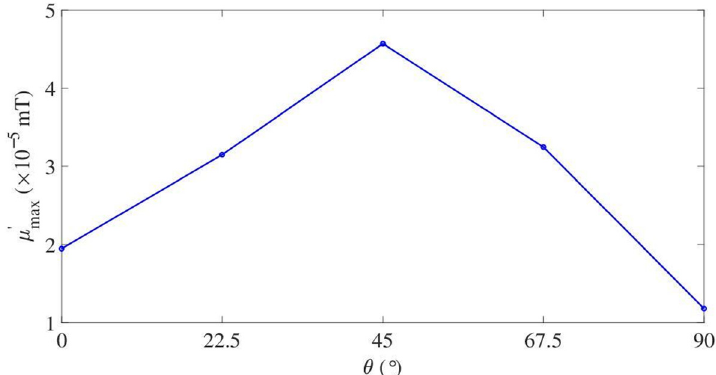
Figure 10. Maximum differential permeability relative to angle θ for specimen 1 .